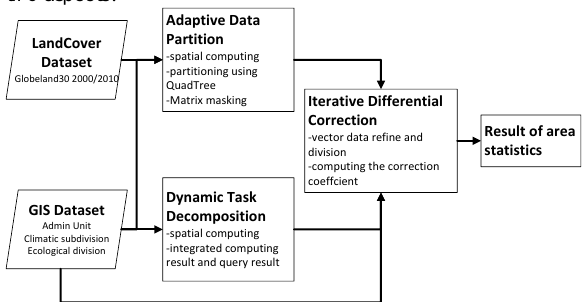
Figure 2 . An overview of the data processing and management strategy. The rectangular box in the middle outlines the main optimized